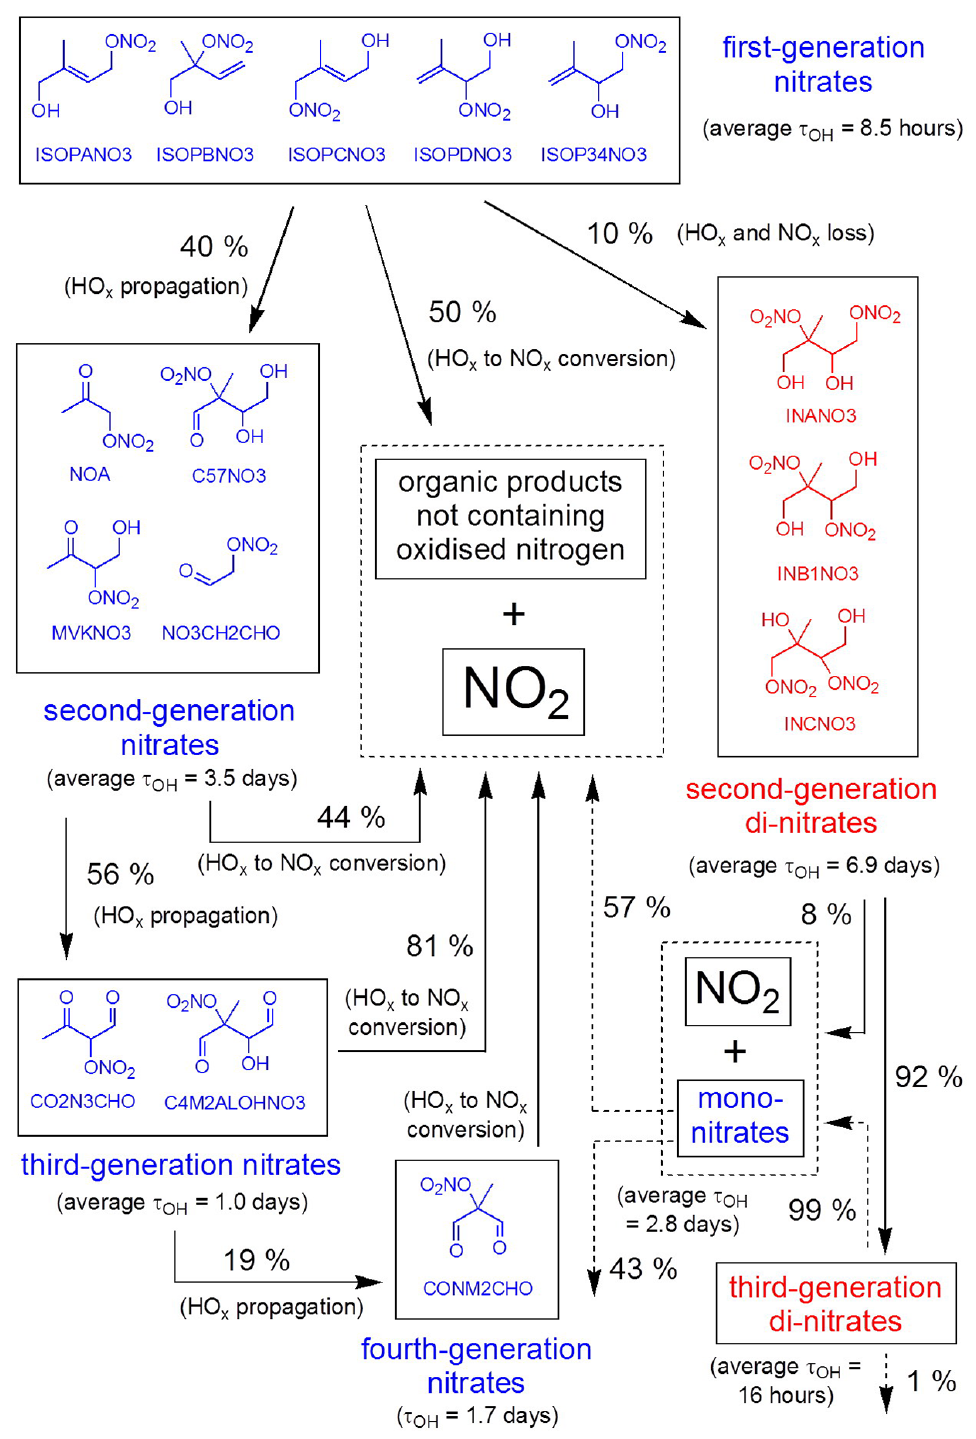
Figure 7. Overview of the OH-initiated degradation of the first-generation nitrates in MCM v3.3.1, based on the calculated distribution at 1ppb NO. Products with one nitrate group are shown in blue, and those with two nitrate groups are shown in red. Where sets of species are shown, these collectively account for ≥ 90% of the nitrate yield in the given category. Representative average lifetimes ( τ OH ) for reactions of the groups of products with OH are shown, based on [OH] = 10 6 moleculecm − 3